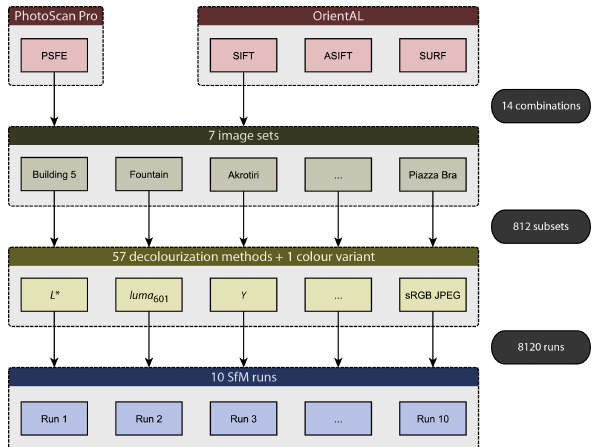
Figure 2. An overview of all possible processing